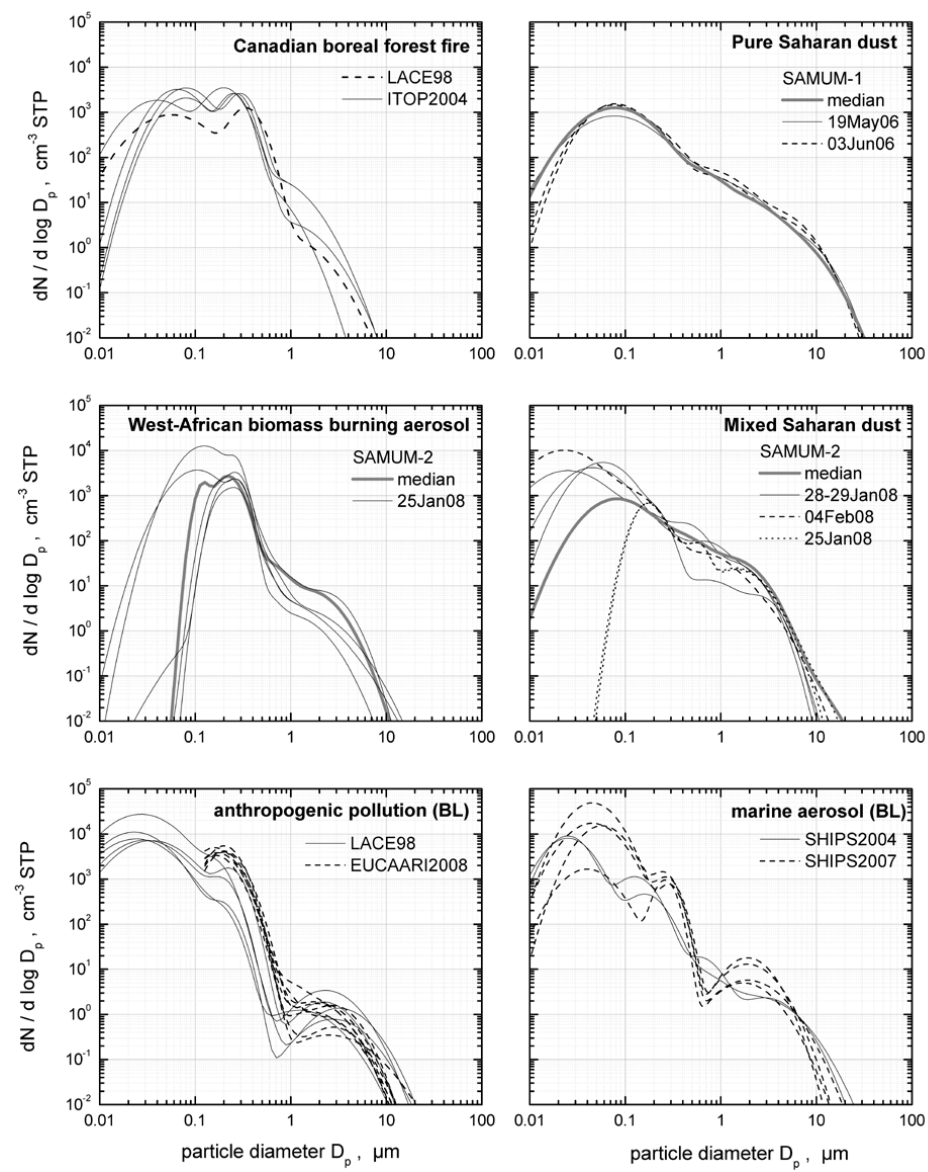
Fig. 7. Representative particle number size distributions for the classified aerosol types: Top left: Canadian boreal forest fire aerosol (LACE98 (Petzold et al., 2002) and ICARTT-ITOP 2004 (Petzold et al., 2007)); mid left: biomass burning aerosol from West African savannah fires (SAMUM-2 (Weinzierl et al., 2011)); bottom left: anthropogenic pollution aerosol over Central Europe (LACE98 (Petzold et al., 2002) and EUCAARI 2008 (Hamburger et al., 2012)); top right: pure Saharan mineral dust over Morocco (SAMUM-1 (Weinzierl et al., 2009)); mid right: Saharan mineral dust mixed with biomass burning aerosol over Cape Verde Islands (SAMUM-2 (Weinzierl et al., 2011)); bottom right: marine boundary layer aerosol over the North Atlantic (SHIPS 2004 (Petzold et al., 2008) and SHIPS 2007). Respective lidar ratios vary from less than 60 sr to 68